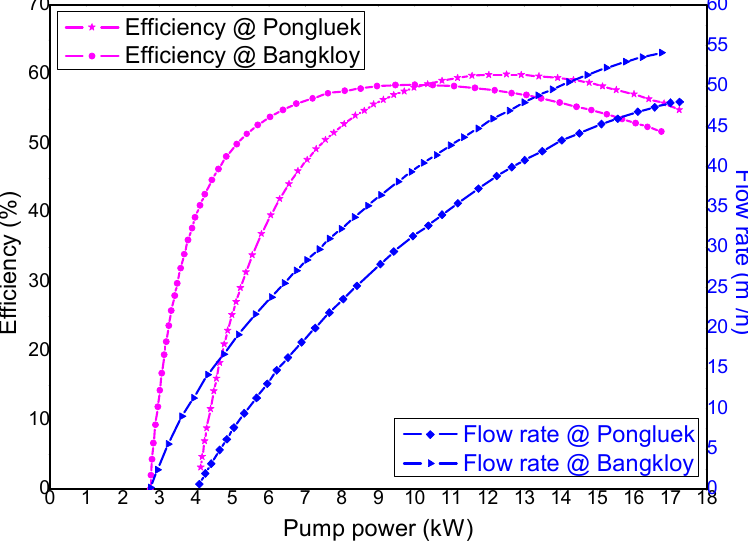
Figure 10. Submersible pump efficiency and flow rate corresponding to its power input in two installed locations with different heads: a 64-m head at Pongluek and a 48-m head at Bangkloy.